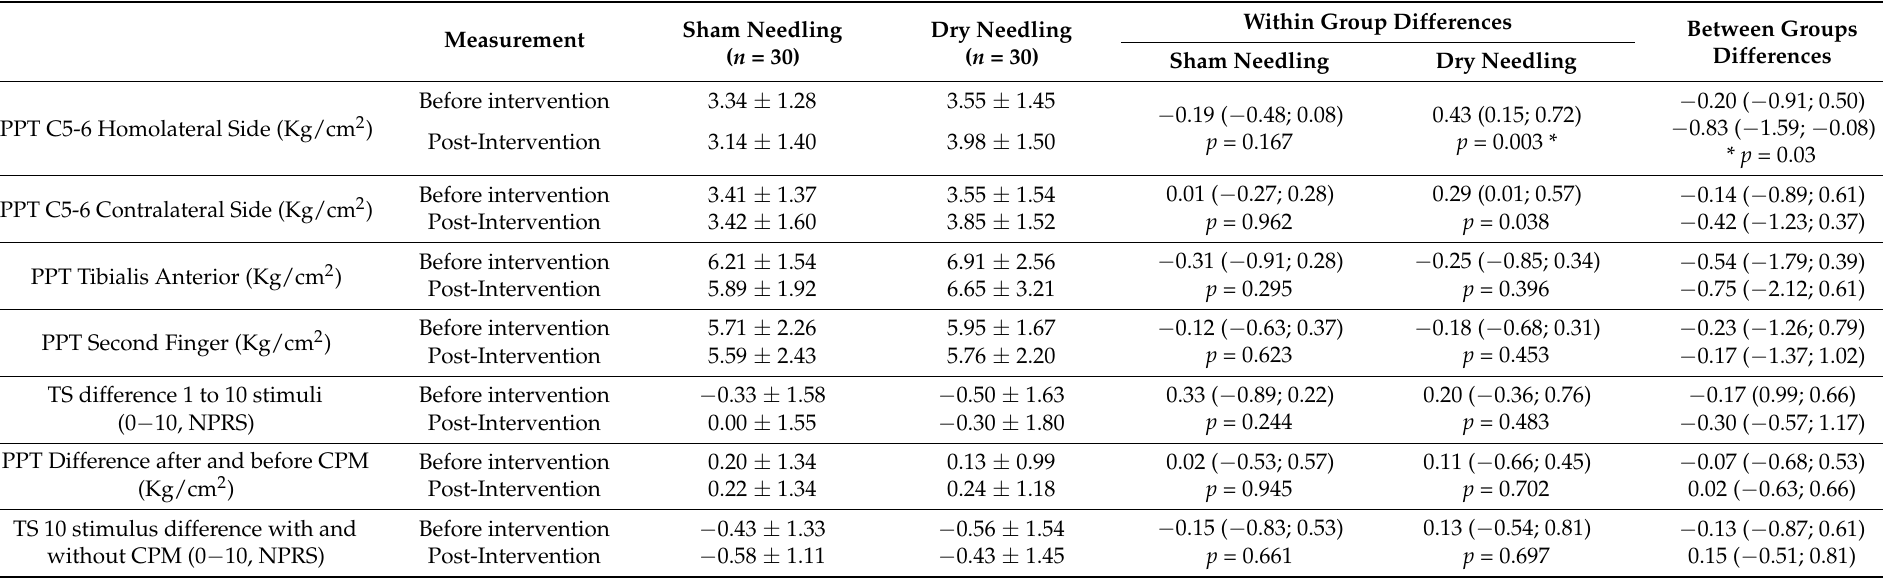
Table 4. Psychophysical outcomes, pain pressure thresholds, and quantitative sensory testing differences within and between groups. Within Group Differences Between Groups Sham Needling Dry Needling Measurement DifferencesSham Needling Dry ( n = 30) ( n = 30)